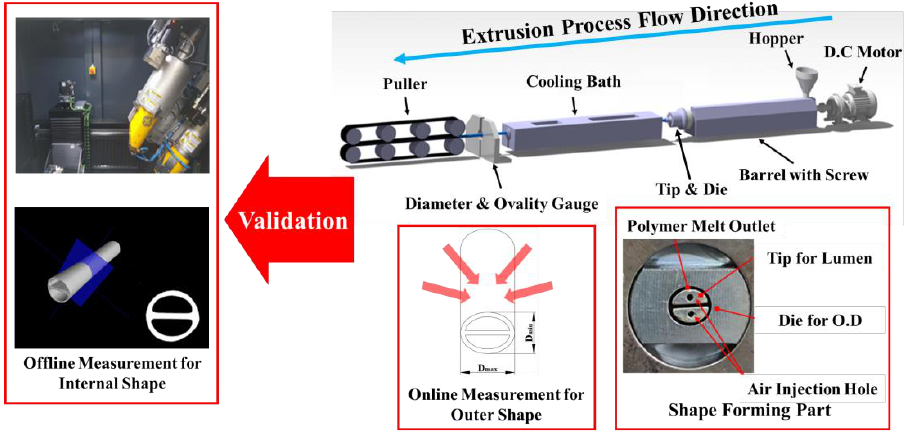
Figure 3. The extrusion system for multi lumen tube manufacturing, diameter/ovality gauge and CT scanner used for validation.